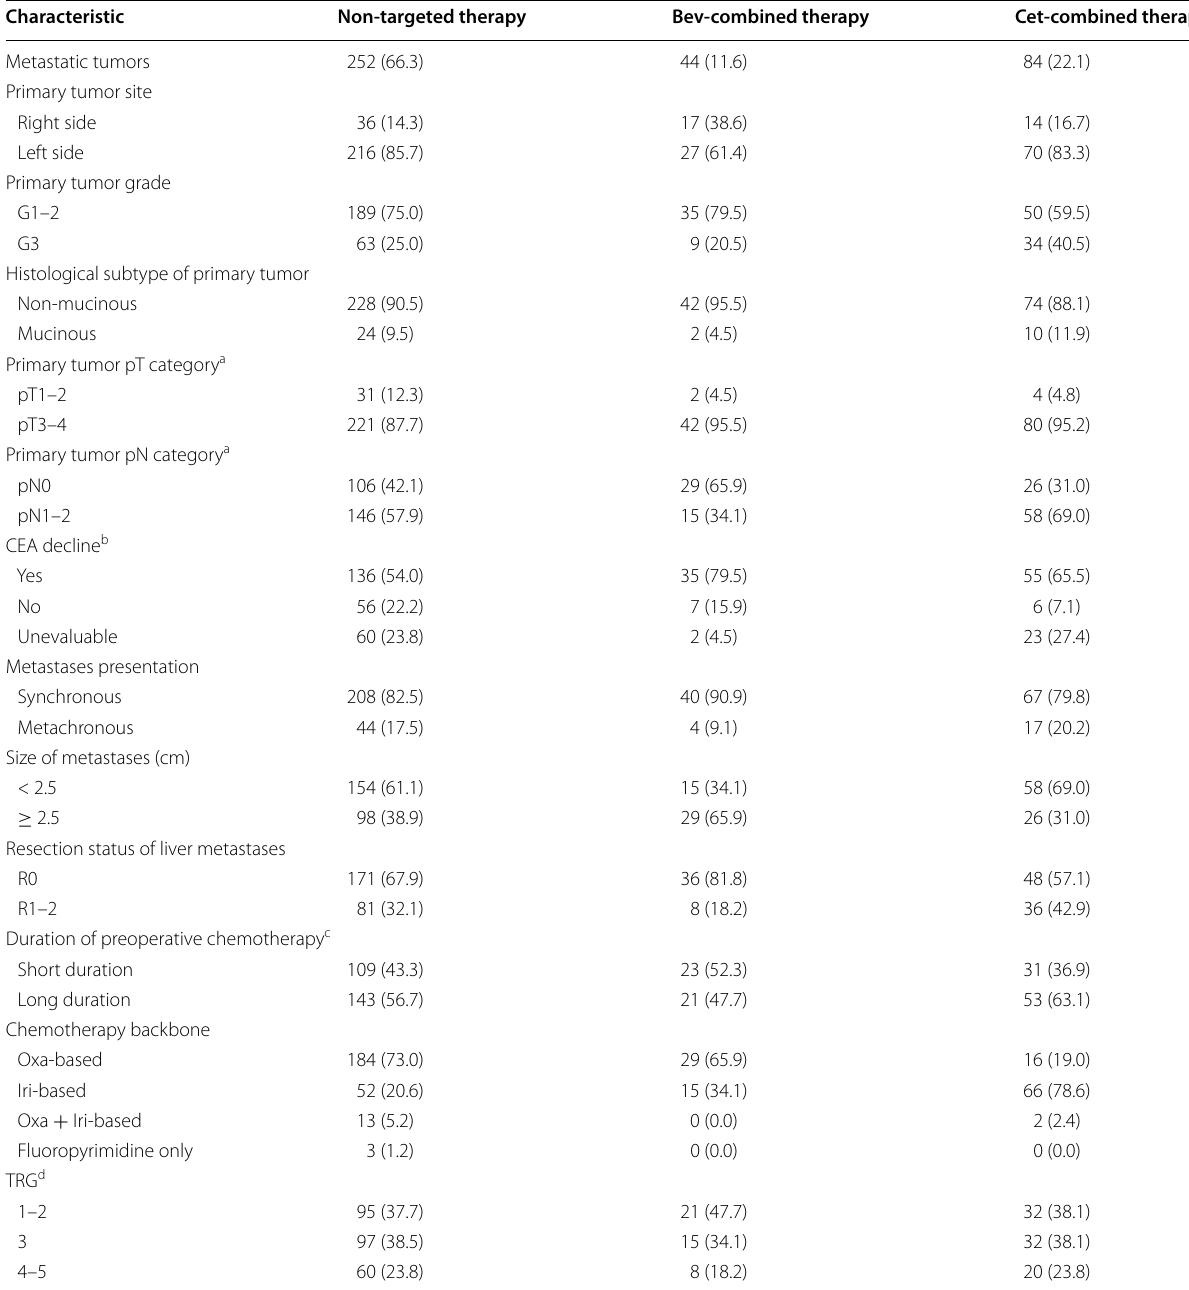
Table 2 Clinicopathologic characteristics of patients based on liver metastatic